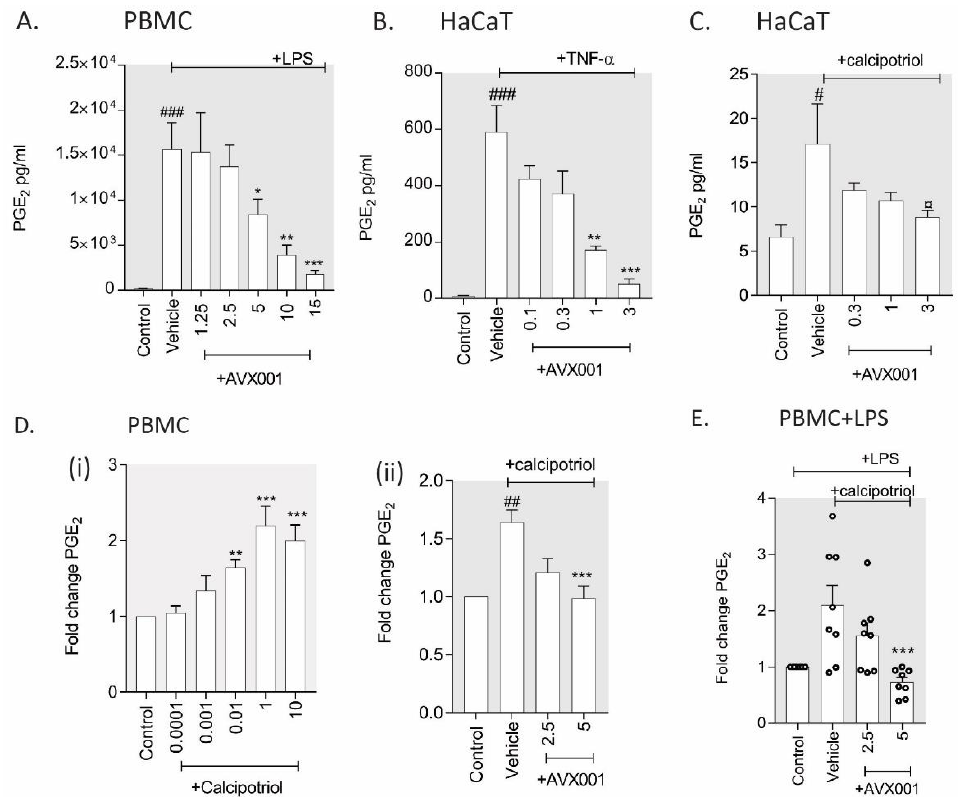
Figure 1. E ff ect of AVX001 on pro-inflammatory eicosanoid production. ( A ) PBMC were pre-incubated with AVX001 ( µ M) and stimulated with lipopolysaccharide (LPS) (10 ng / mL, 72 h). ( B ) Immortalized keratinocytes (HaCaT) were pre-incubated with AVX001 ( µ M) and stimulated with tumor necrosis factor (TNF)- α (10 ng / mL, 72 h). ( C ) HaCaT were pre-incubated with AVX001 ( µ M) and stimulated with calcipotriol (10 nM, 72 h). ( D ) ( i ) PBMC were treated with calcipotriol ( µ M) for 72 h, ( ii ) PBMC were pre-treated with AVX001 ( µ M) and stimulated with calcipotriol (10 nM, 72 h). ( E ) PBMC were pre-incubated with AVX001 ( µ M) and stimulated with calcipotriol (10 nM, 72 h) or vehicle in the presence of LPS (10 ng / mL). PGE 2 levels in supernatants were determined by ELISA and reported as either pg / mL ( A – C ), or as the fold change in PGE 2 levels over unstimulated ( D ) or LPS-stimulated ( E ) controls. Data are the mean ± SEM of ≥ 4 individuals (PBMC) or 3 replicates (HaCaT). Statistical significance was calculated by one-way ANOVA with Dunnett’s post-analysis, or, for normalized data, using the Kruskal–Wallis test with Dunn’s post-analysis; # p < 0.05, ## p < 0.01, or ### p < 0.005 versus unstimulated control and * p < 0.05, ** p < 0.01 versus vehicle-treated control.